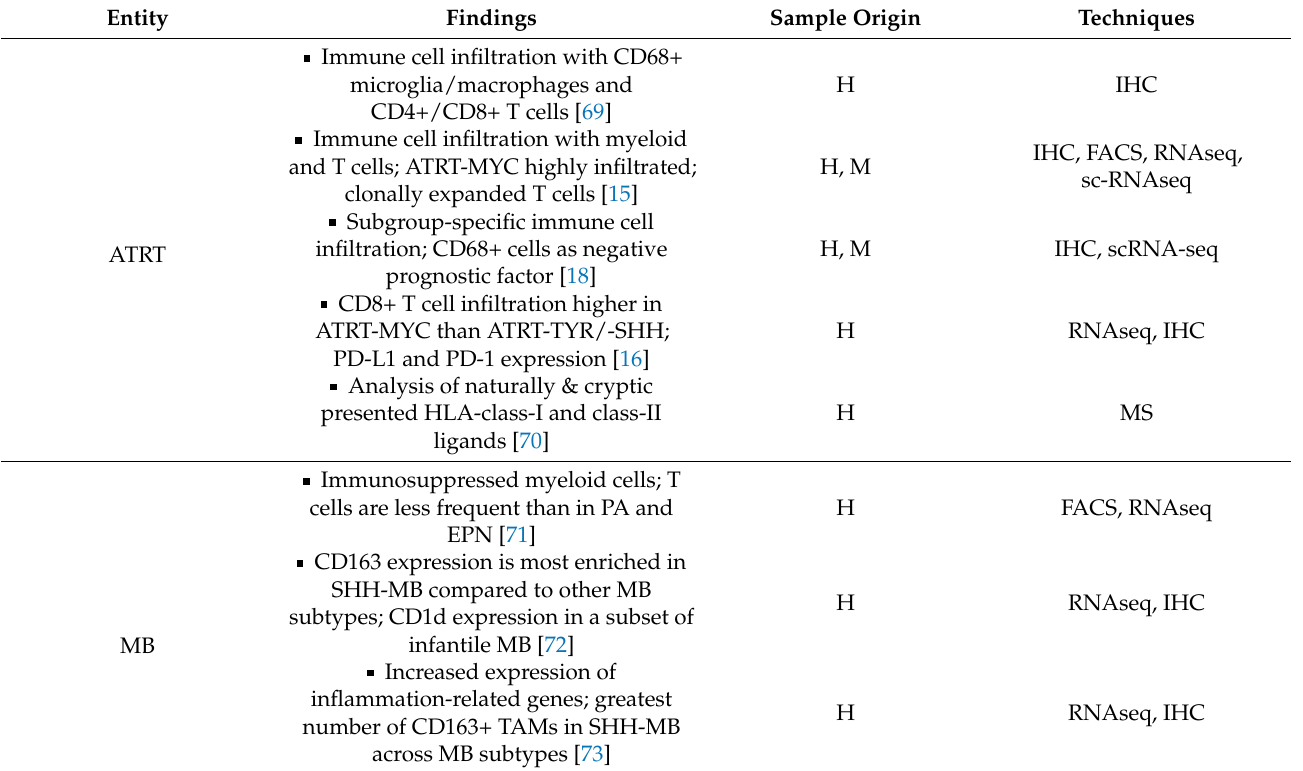
Table 2. Immune profiling studies in pediatric brain